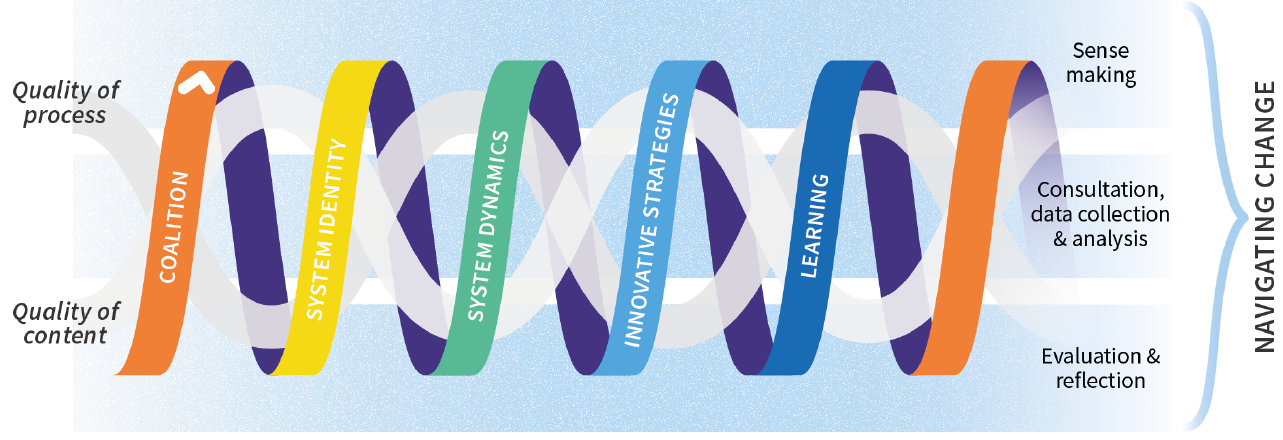
Fig. 5. The Wayfinder framework is operationalized through a process in five phases. The process is set up to balance the need for running a legitimate, fair, and transparent process with generating high-quality data, scientifically sound analyses, and producing solid content. The process emphasizes the importance of in-depth learning and reflexive practice for navigating toward more sustainable futures in the Anthropocene, and users are encouraged to iterate between three different modes of thinking. Illustration: E.